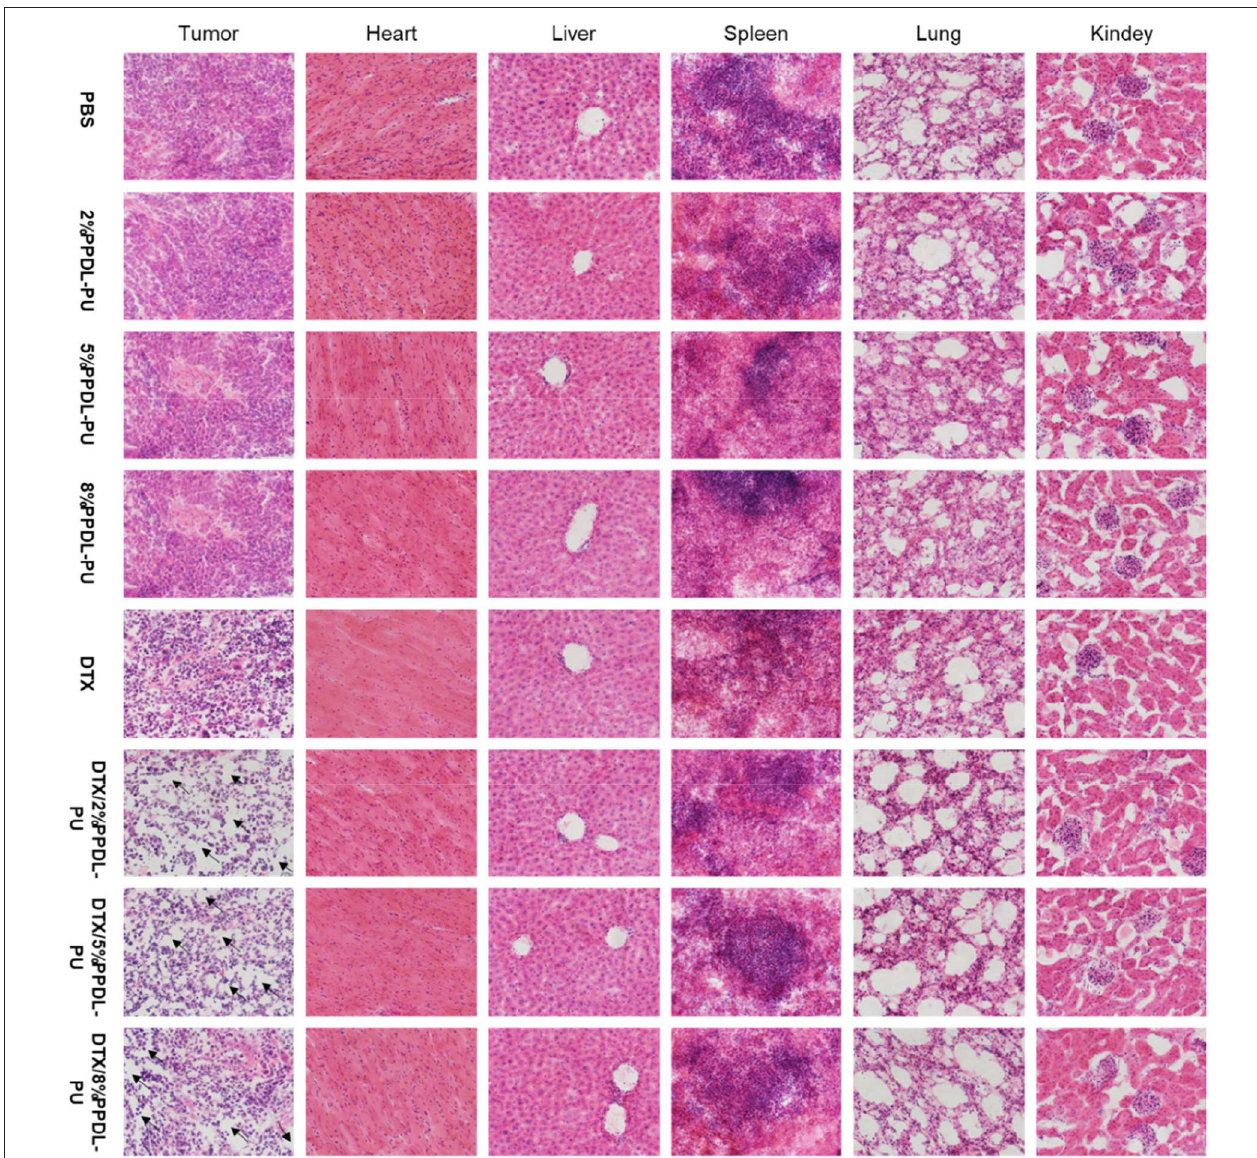
FIGURE 9 | HandE staining analysis of the effects of different drug forms on tumors and major organs (heart, liver, spleen, lung, and kidney).